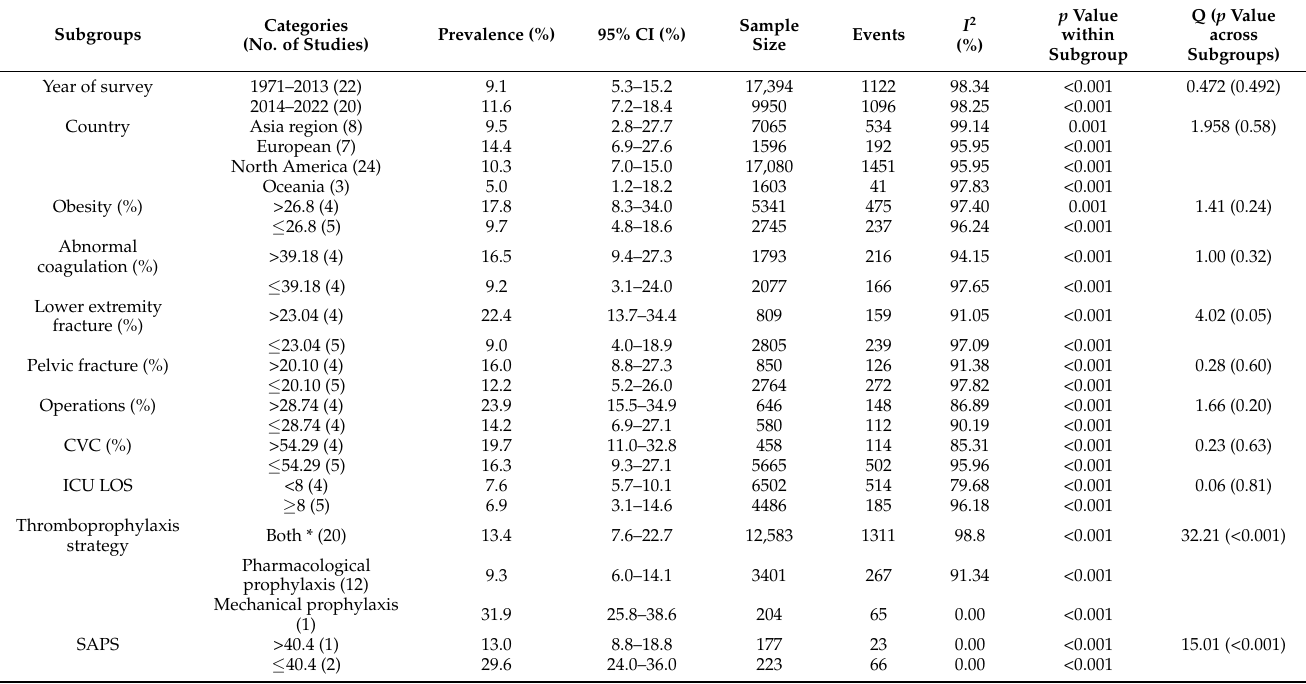
Table 2. Subgroup analyses of prevalence of VTE in ICU patients.